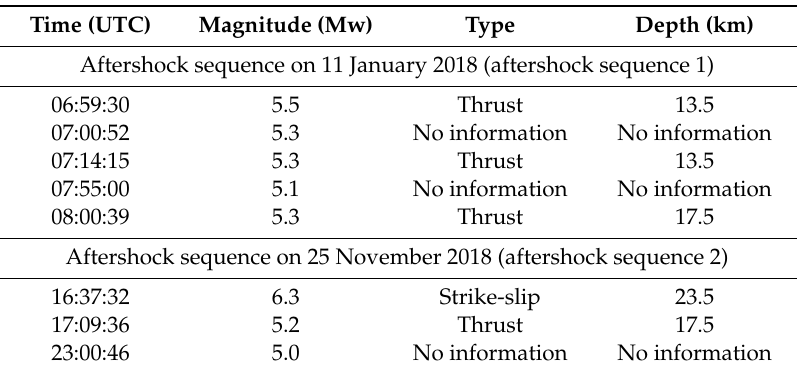
Table 1. Aftershock sequences a